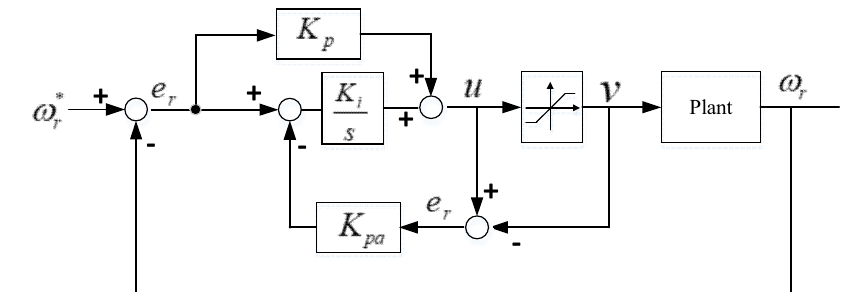
Figure 12. Anti-windup controller (tracking back calculation scheme).